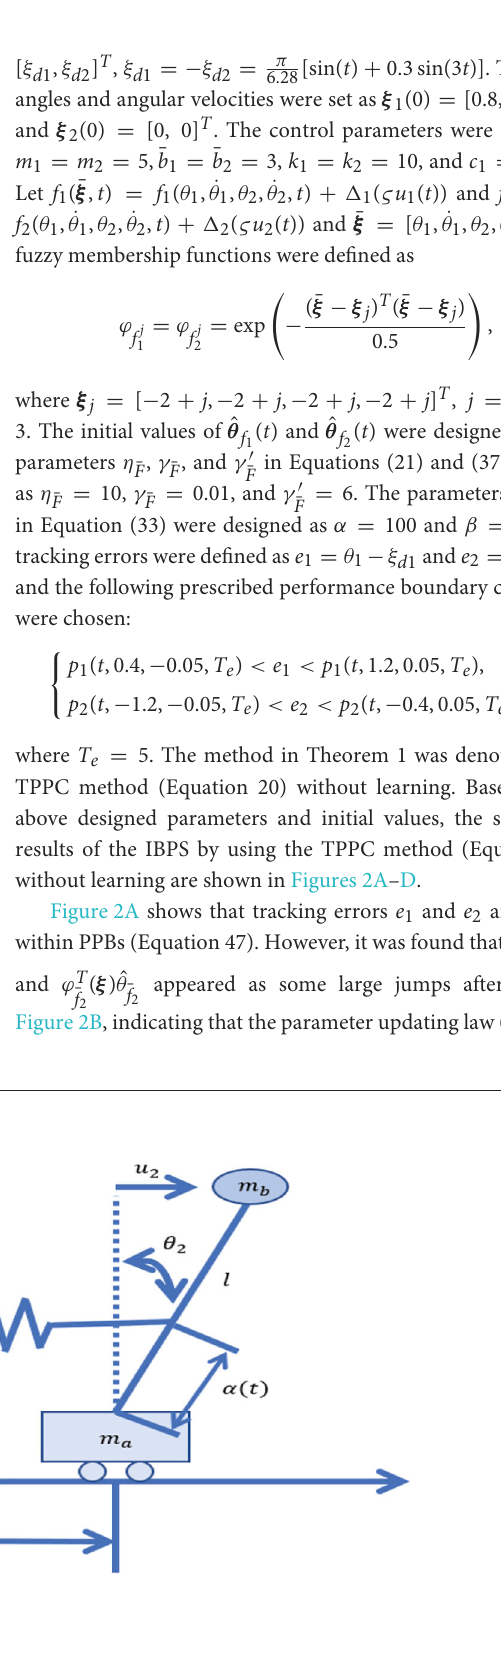
FIGURE1 The inverted double pendulum